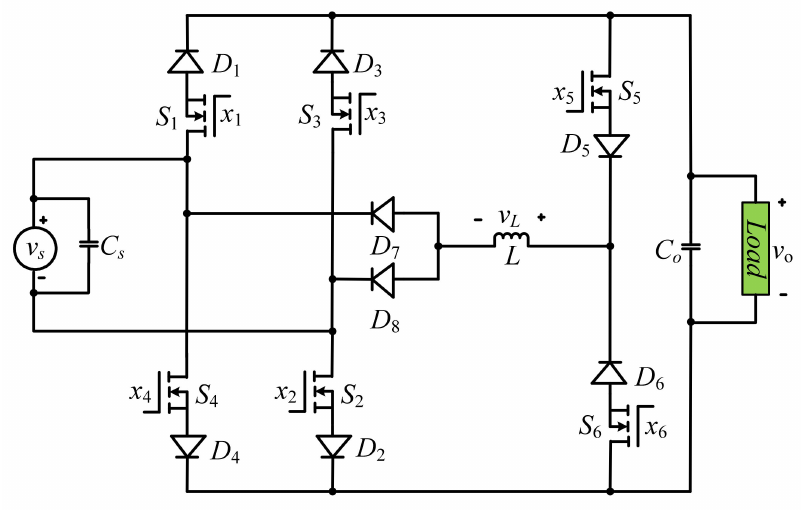
Figure 1. Proposed